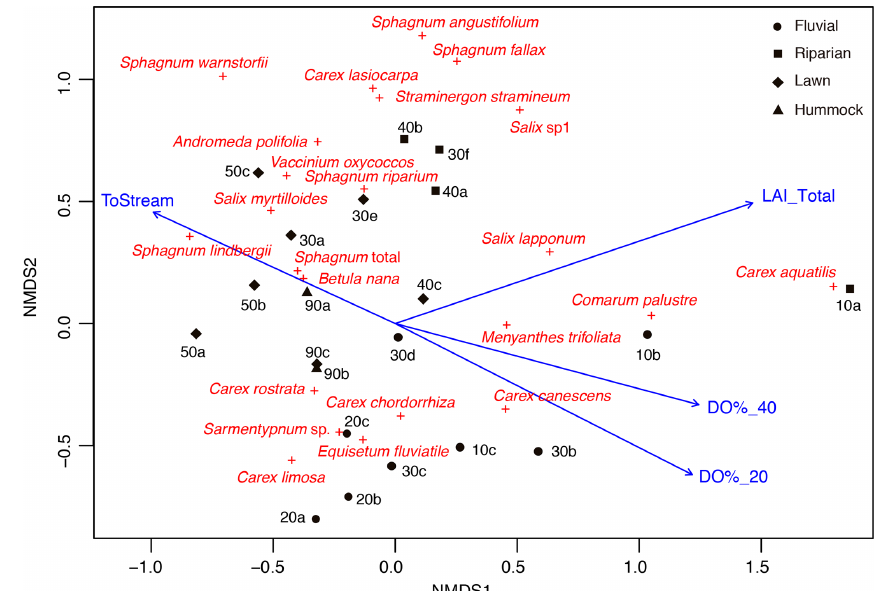
Figure 3. Non-metric multidimensional scaling (NMDS; stress 0.15) ordination showing the peak season (late July) vegetation structure in the sample plots, including distance to stream (ToStream, p = 0 . 042), peak season (early summer) dissolved oxygen concentration at 20cm (DO%_20, p = 0 . 006) and 40cm depths (DO%_40, p = 0 . 015), and peak season (late July) total vascular plant leaf area index (LAI_Total, p = 0 . 003) as fitted environmental variables. Four plant community types that were derived from the regional vegetation data are indicated using different